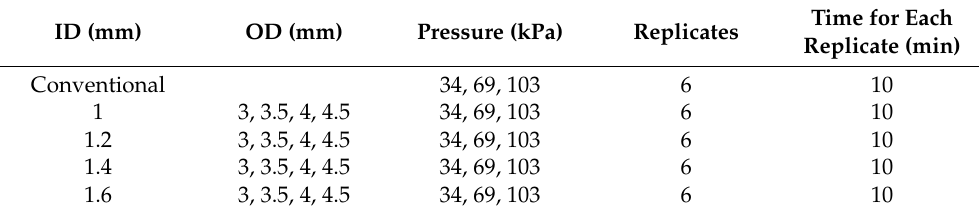
Time for Each Replicate (min)